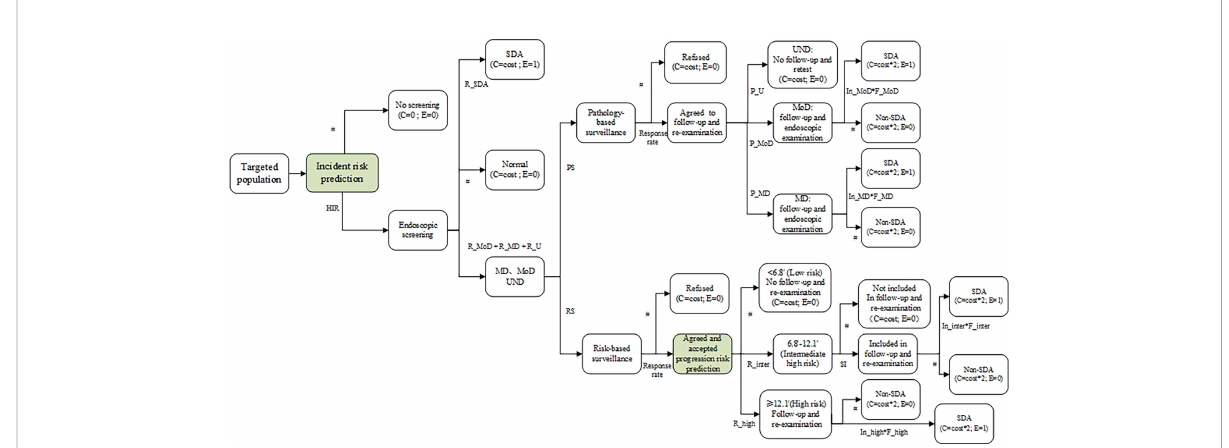
FIGURE 1 Structure of decision tree model for esophageal cancer screening strategies. HIR, High Incident-risk Rate in the prediction model at baseline according to adopted cutoff value and sensitivity ( “ 1 ” refers to not using prediction model and screening for all enrolled participants at baseline). R_SDA, Detection rate of SDA cases for ESCC in the initial examination. R_MoD, Detection rate of Moderate dysplasia cases in the initial examination. R_MD, Detection rate of Mild dysplasia cases in the initial examination. R_U, Detection rate of subjects with visualization of unstained areas and non-dysplasia pathology diagnosis in the initial examination. PS, Adopting pathology-based surveillance. “ 0 ” refers to negative and “ 1 ” refers to positive. P_MD, Proportion of subjects with a diagnosis of Mild Dysplasia among all subjects with a diagnosis of MD, MoD or U. P_MoD, Proportion of subjects with a diagnosis of Moderate Dysplasia among all subjects with a diagnosis of MD, MoD or U. P_U, Proportion of subjects with a diagnosis of Unstaining and non-dysplasia among all subjects with a diagnosis of MD, MoD or U. In_MoD, Incidence rate (per person-year) of SDA cases in the surveillance among subjects with a diagnosis of Moderate Dysplasia. ( “—” refers to no pathology-based surveillance adopted); F_MoD, Average follow-up interval (years) between baseline screening and re-examination for subjects with a diagnosis of Moderate Dysplasia. In_MD, Incidence rate (per person-year) of SDA cases in the surveillance among subjects with a diagnosis of Mild Dysplasia. ( “—” refers to no pathology-based surveillance adopted); F_MD, Average follow-up interval (years) between baseline screening and re-examination for subjects with a diagnosis of Mild Dysplasia. RS, Adopting Risk-based Surveillance. “ 0 ” refers to negative and “ 1 ” refers to positive. SI, Surveillance for Intermediate high-risk subjects. “ 0 ” refers to negative and “ 1 ” refers to positive. ( “—” refers to no